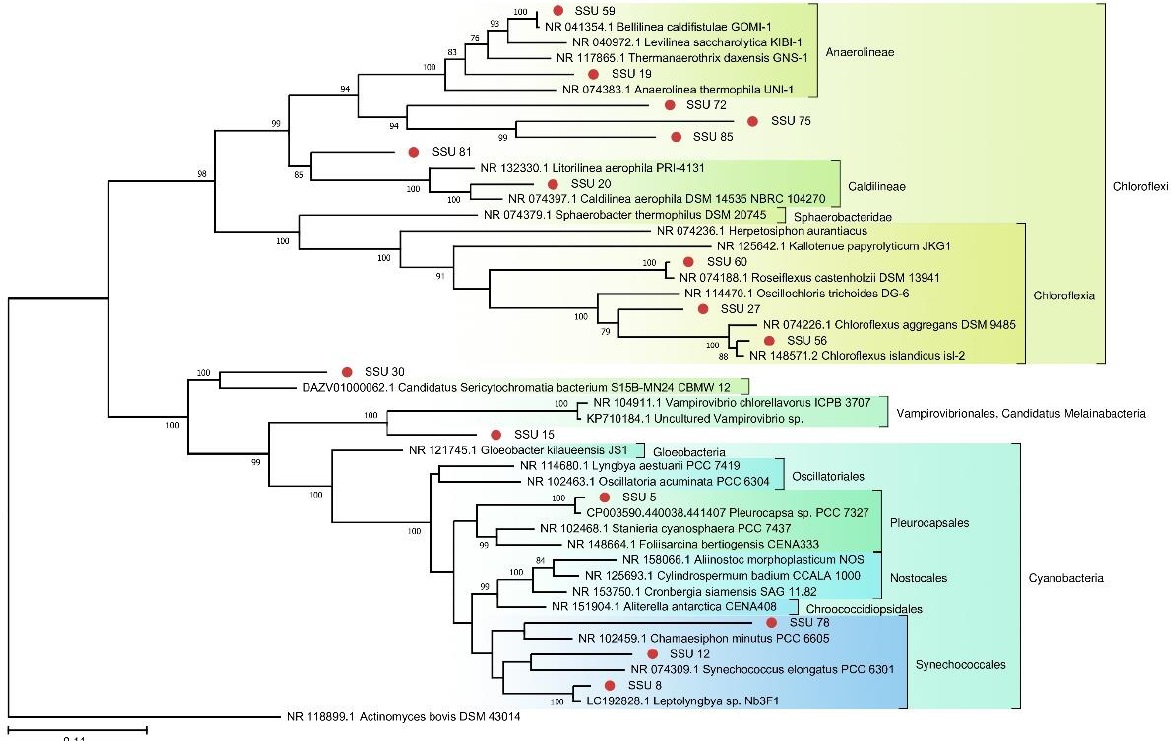
Figure 5. The phylogenetic tree of SSU rRNA sequences of photosynthetic representatives of the TRT community and their closest homologs from the NCBI nt database (The Tamura–Nei substitution model with gamma distribution and invariant sites (TN93 + G + I)).